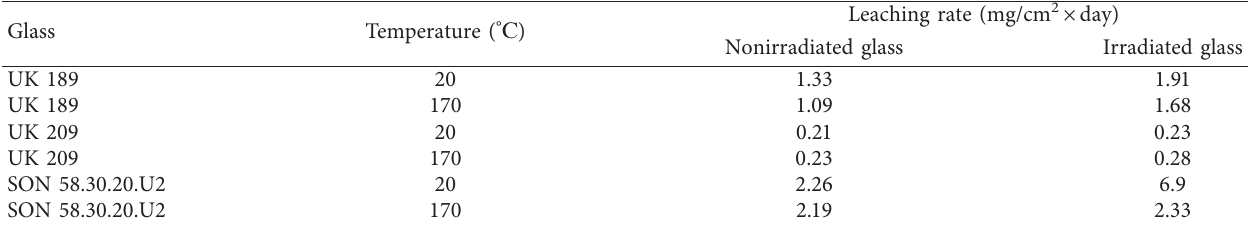
Table 7: Changes in leaching rate of glasses caused by α -irradiation at a dose of 1.1 × 10 18 α -decays/g.